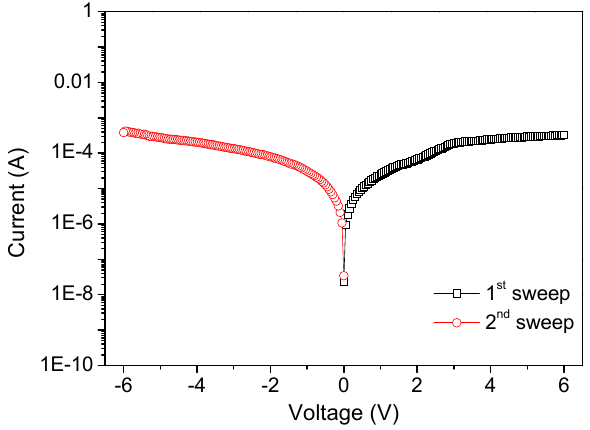
Figure 11. I - V characteristics of this control Figure 11. I ‐ V characteristics of this control device. Figure 11. I ‐ V characteristics of this control device.